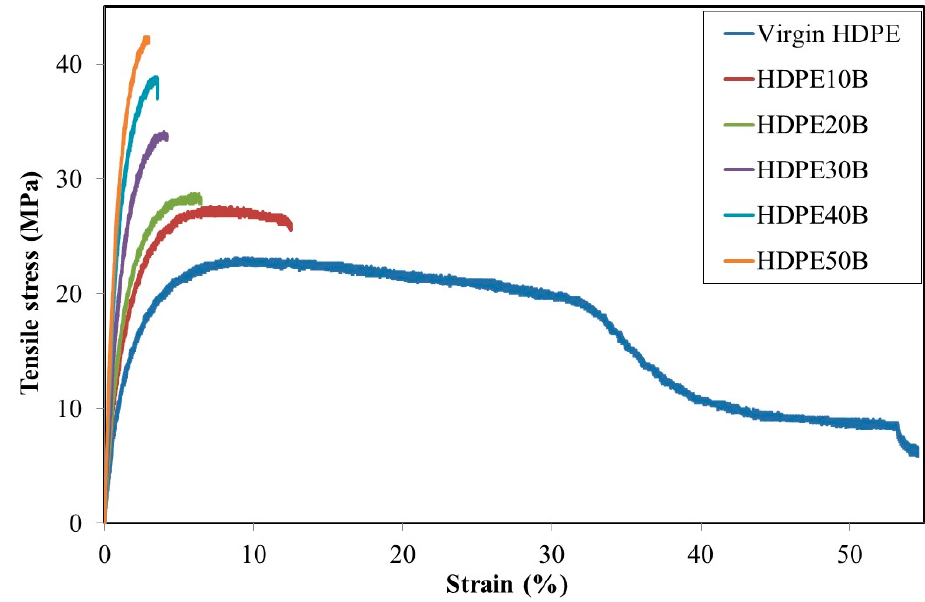
Figure 2. Tensile test: stress–strain behavior of HDPE/birch fiber composites. Table 2. Mechanical properties of HDPE/birch fiber composite